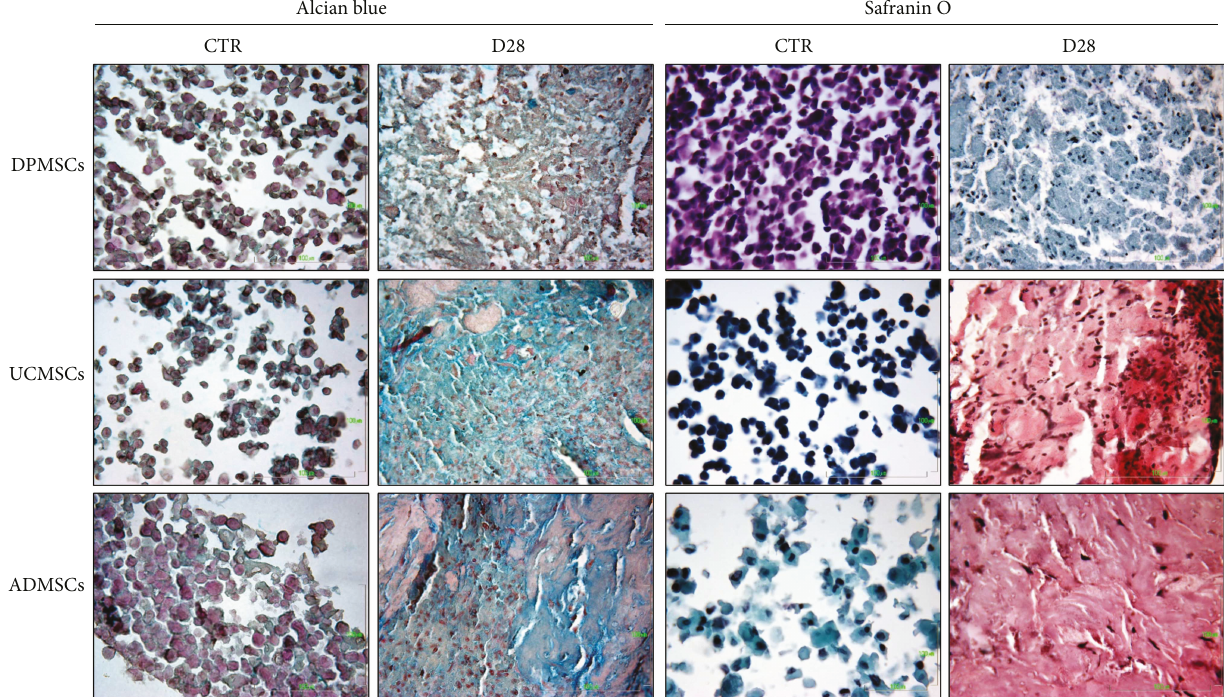
Figure 5: Alcian blue and safranin O staining on MSC micromasses, previously treated with 100 μ M CoCl chondrogenic di ff erentiation up to 28 days. The images are representative of three di ff erent experiments (magni fi cation 400x; bar: 100 μ